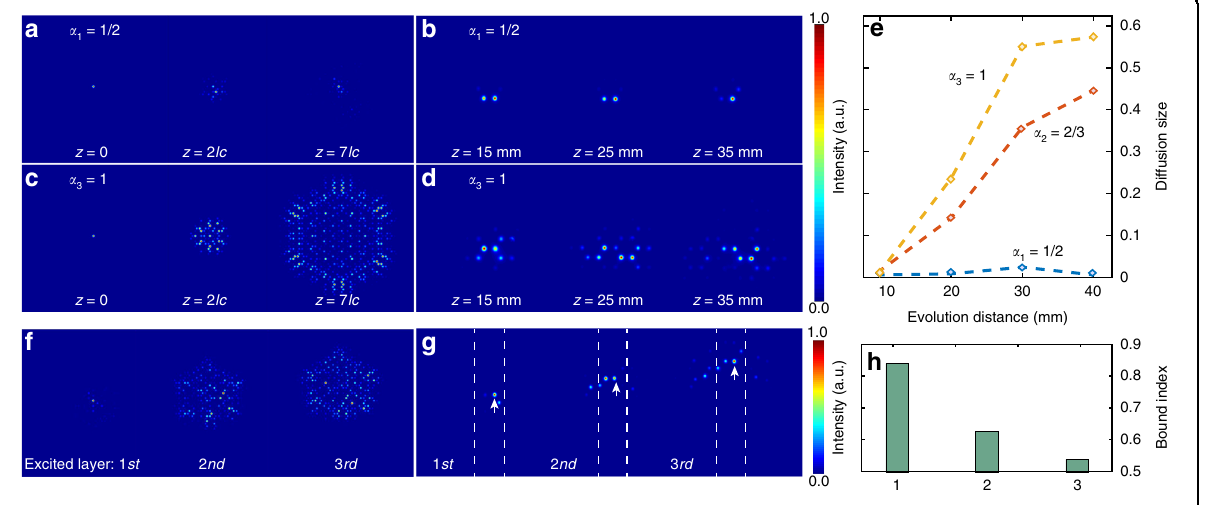
The generation and transmission of vortex states in the emulated cosmic strings